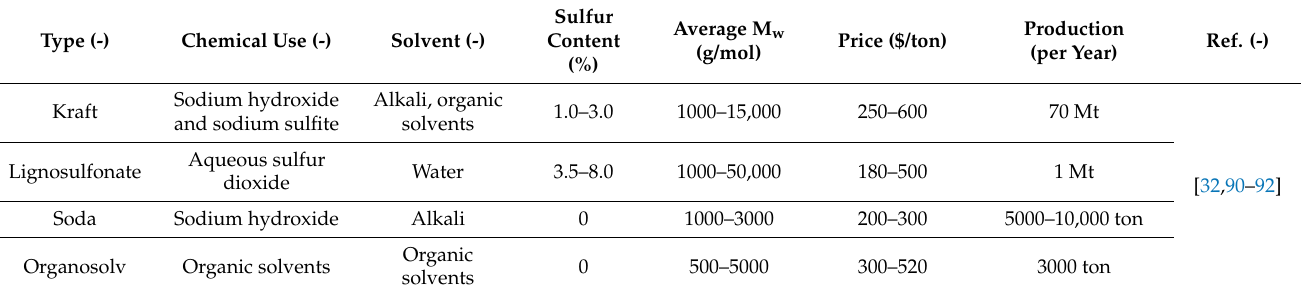
Table 4. Chemical and general properties of technical